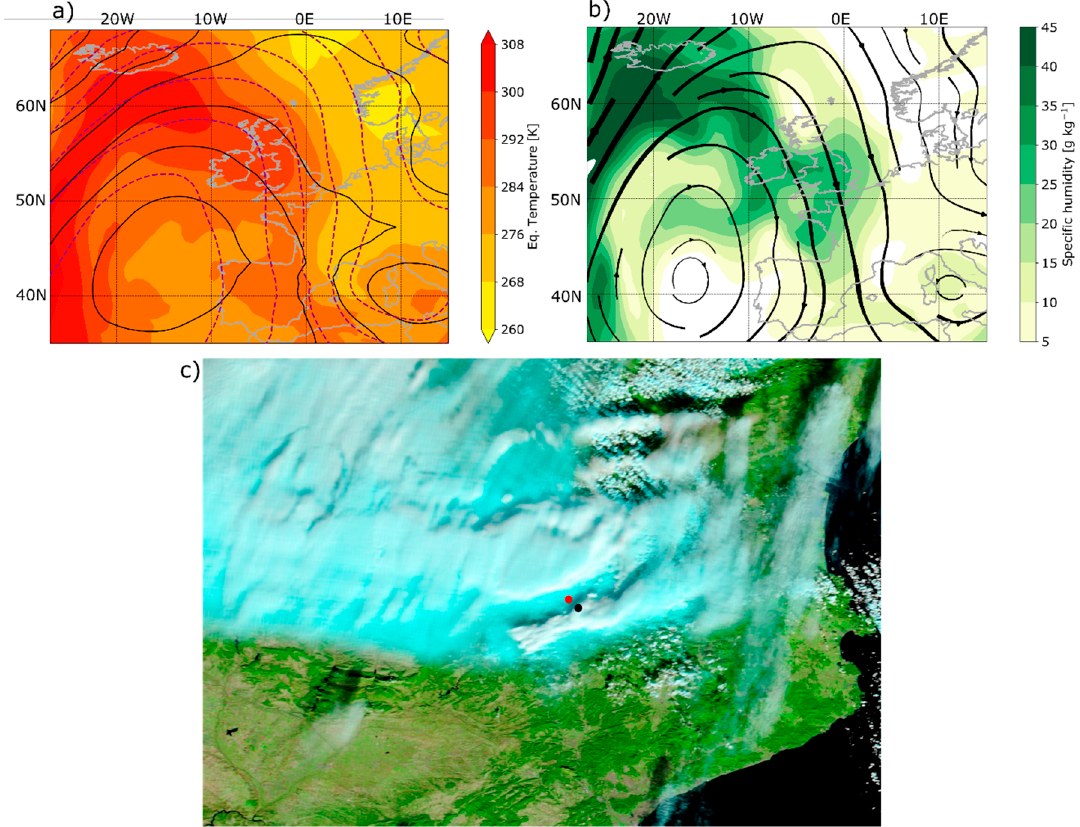
Figure 2. Upper panels display ERA-Interim reanalysis data for 15 Jan 2017 12 UTC showing: ( a ) Geopotential height [gpm] at 850 hPa and 500 hPa (black solid lines and purple dashed lines respectively) and equivalent temperature at 850 hPa (shaded colours); and ( b ) streamlines (line width proportional to the wind speed) and specific humidity at 700 hPa (yellow-green shaded colours). ( c ) MODIS corrected reflectance in false colour (Bands 7-2-1) measured by the Terra satellite on 15 Jan 2017 10:35 UTC. Black and Red dots indicate respectively the position of the MRR and the UHF wind- profiler.